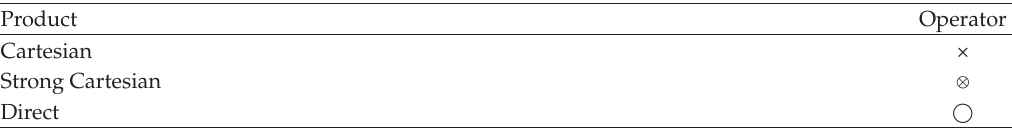
Table 1: Operators of graph